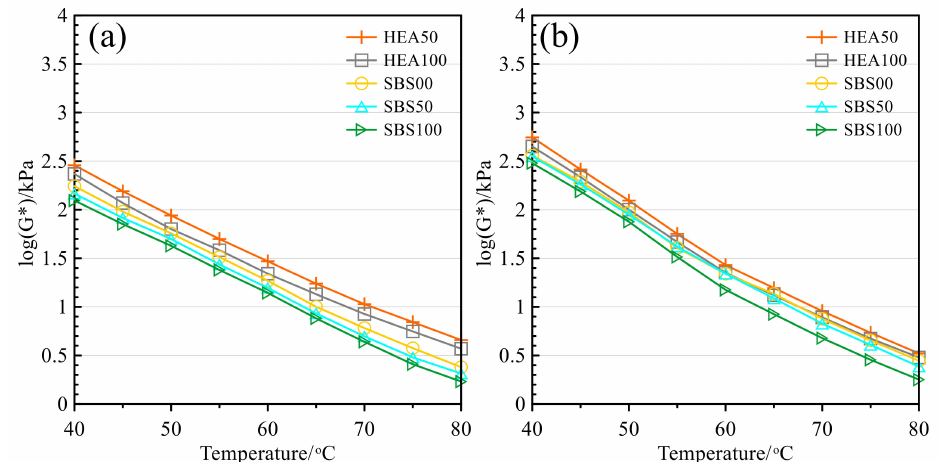
Figure 6. Complex modulus: ( a ) Before TFOT; ( b ) After TFOT.